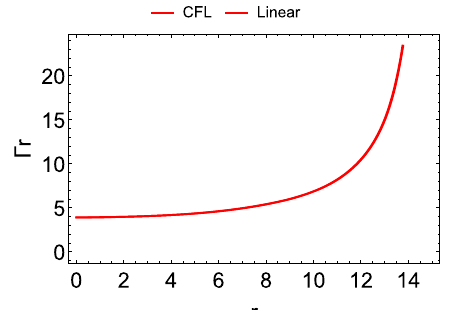
Fig. 4 Variation of anisotropy with radial coordinate